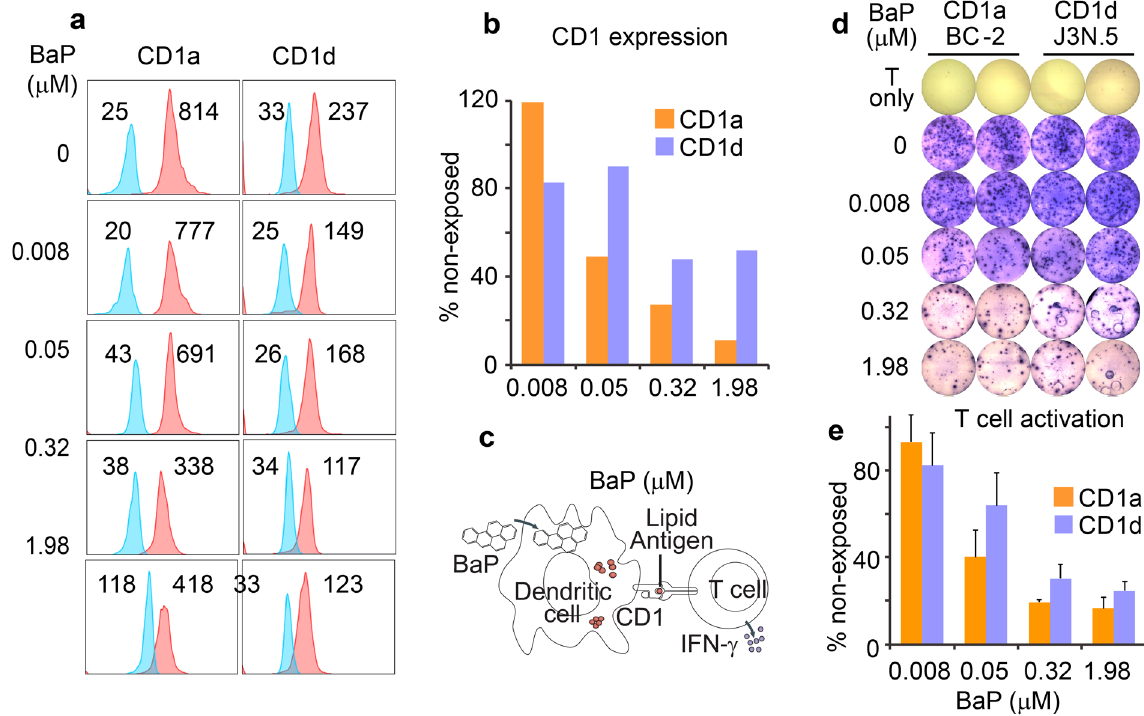
Figure 1. Inhibition of CD1 expression and T cell activation by BaP. CD1a and CD1d proteins (Red) on human DCs were tested by flow cytometry and plotted with non-stained controls that reflect the autofluorescence of BaP (Blue). To estimate CD1 expression, mean fluorescence intensity (MFI) was labeled by the histogram ( a ). Then, the MFI of stained samples was normalized to that of non-stained samples and compared with non- exposed DCs ( b ). T cell activation represented by IFN- γ production was stimulated by DCs and tested with an immunospot assay, as schematically shown ( c ). The immunospot plate ( d ) and quantified results ( e ) show that the activation of CD1a-restricted BC-2 cells and CD1d-restricted J3N.5 cells was inhibited in a dose-dependent manner by DCs exposed to BaP. Standard errors from technical replicates of each sample are shown. Data are from one experiment performed with blood cells obtained from an independent donor. Three experiments were performed with similar